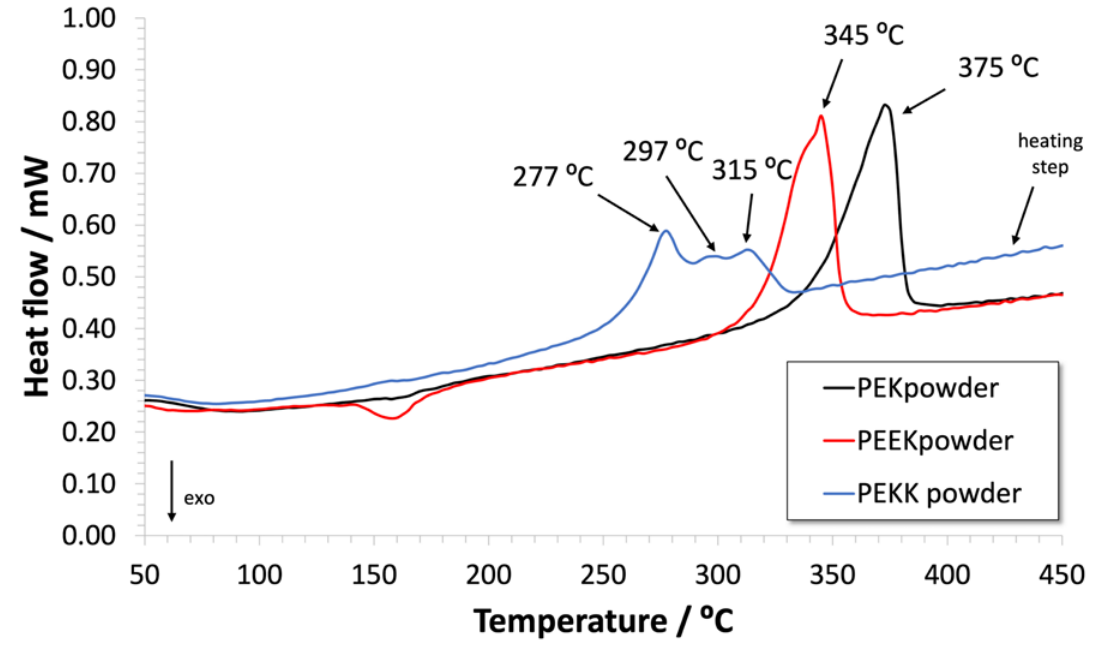
Figure 7. DSC thermograms for PEK, PEEK and PEKK powders for one heating cycle.